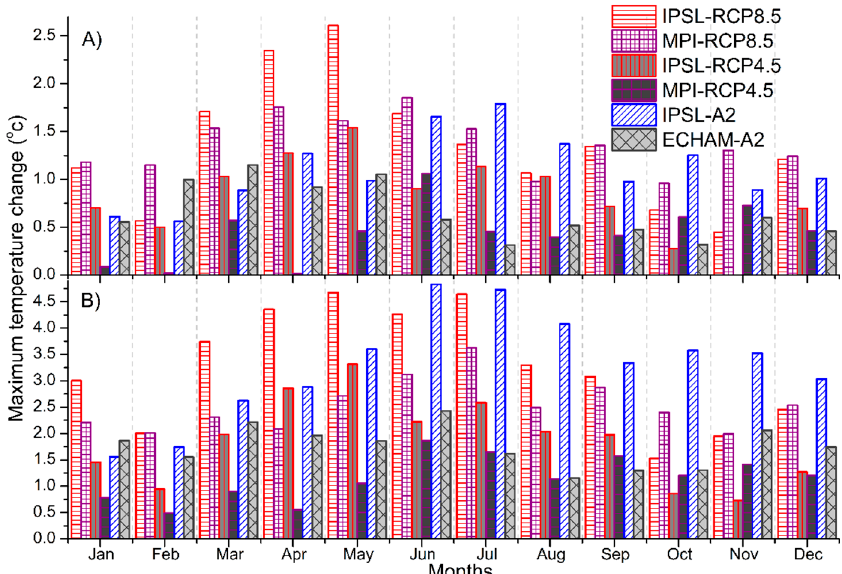
Figure 9. Changes of the monthly maximum temperature for ( A ) the near future period of 2021–2050 and ( B ) the far future period of 2071–2100, with respect to the baseline.